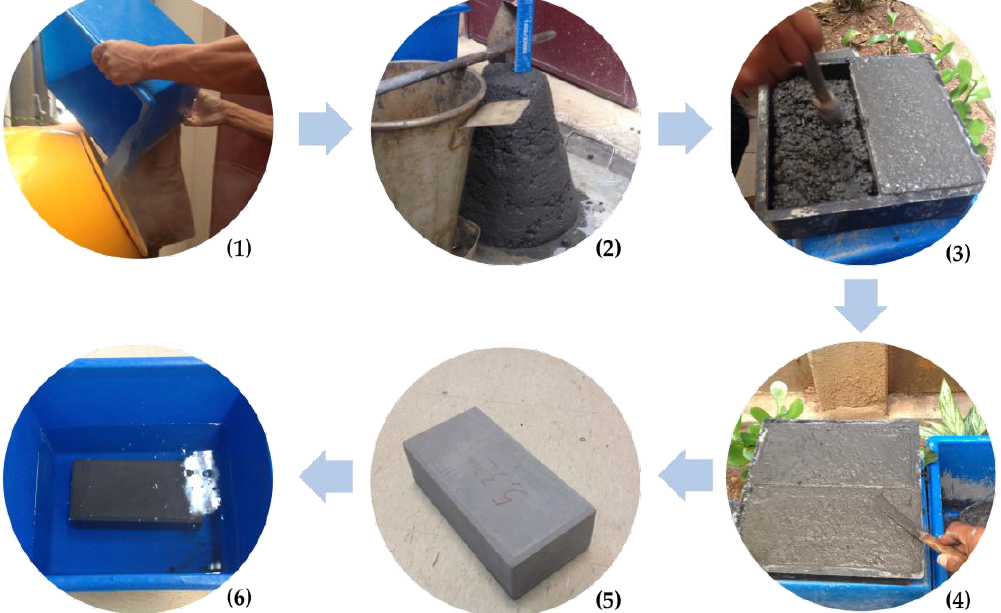
Figure 7. Production steps for concrete paving blocks ( 1 ) mixing of materials, ( 2 ) slump test, ( 3 ) molding and thickening, ( 4 ) surface finishing, ( 5 ) blocks after de-molding, and ( 6 ) submerged curing in water.